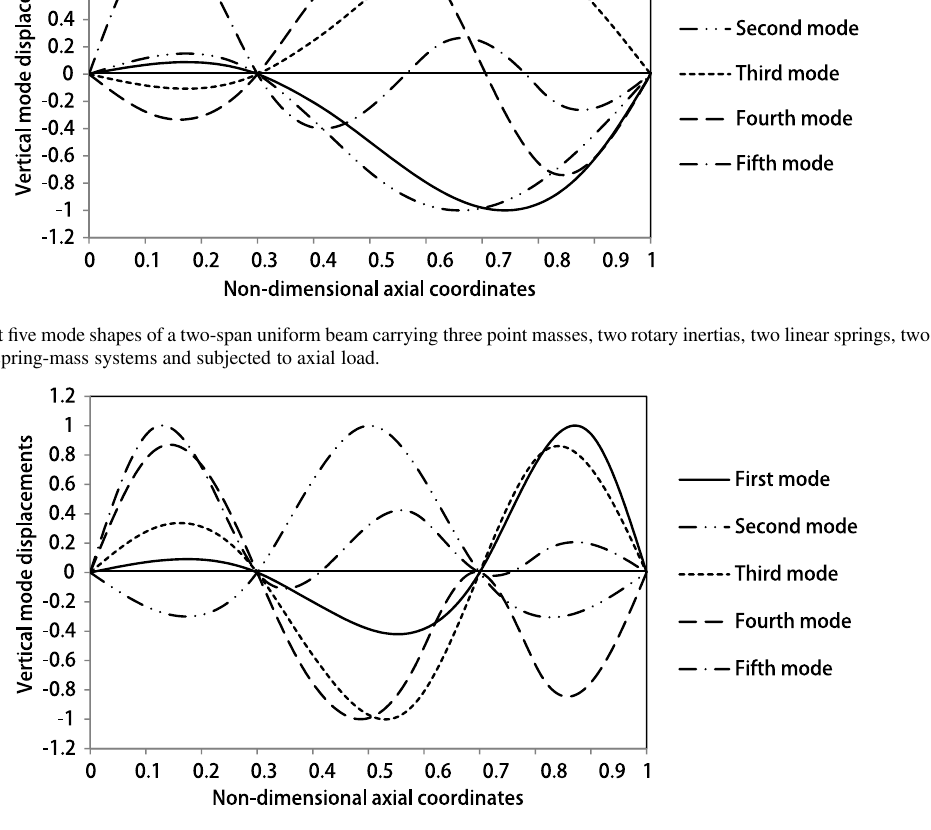
Fig. 9. The lowest five mode shapes of a three-span uniform beam carrying three point masses, two rotary inertias, two linear springs, two rotational springs and two mass spring sytems and subjected to axial